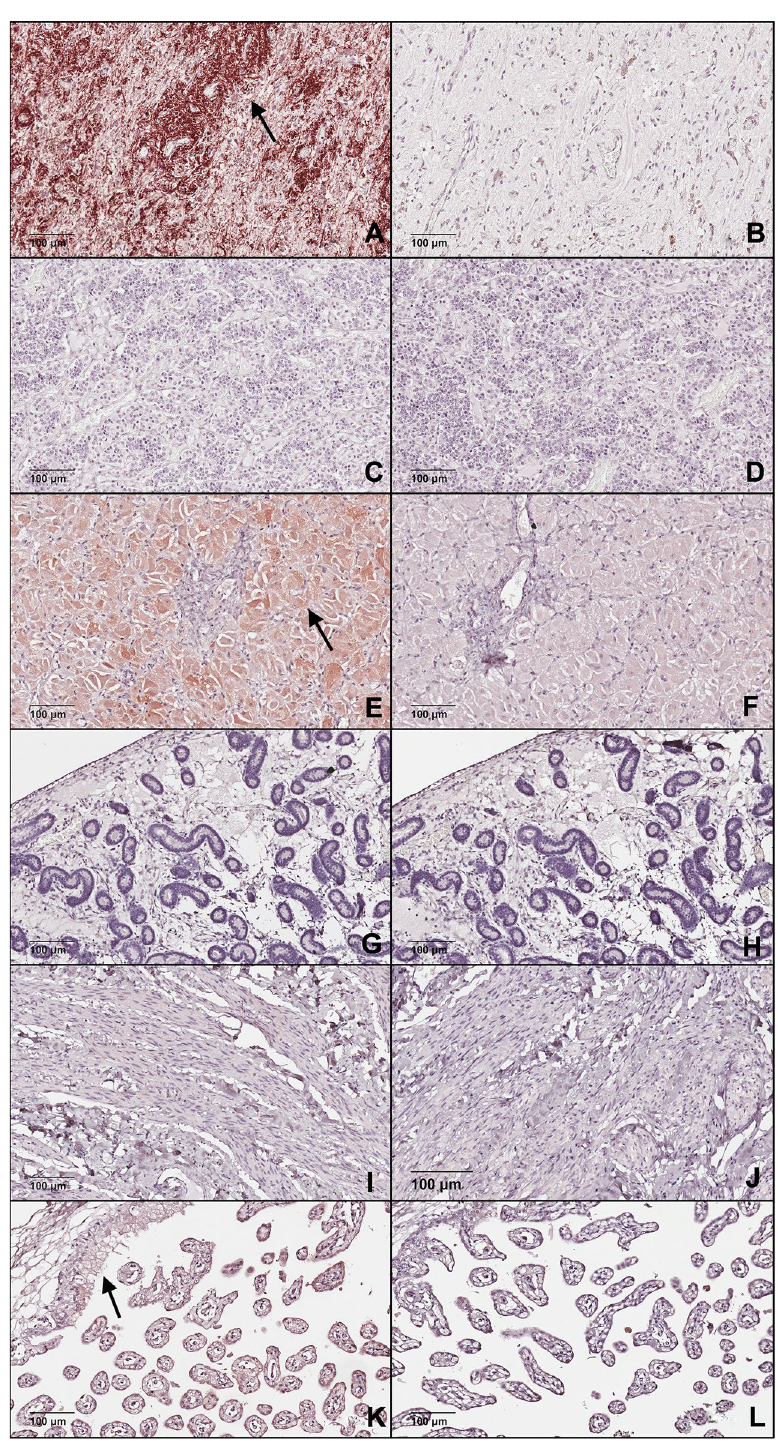
Figure 7. Photomicrograph demonstrating immunolocalization of OXT in: ( A ) neurohypophysis, ( E ) corpus luteum, and ( K ) the placenta and negative staining uptake for OXT is shown in the ( C ) adenohypophysis, ( G ) endometrium and ( I ) myometrium. Black arrow shows specific staining. Negative epitope controls for each tissue ( B , D , F , H , J and L